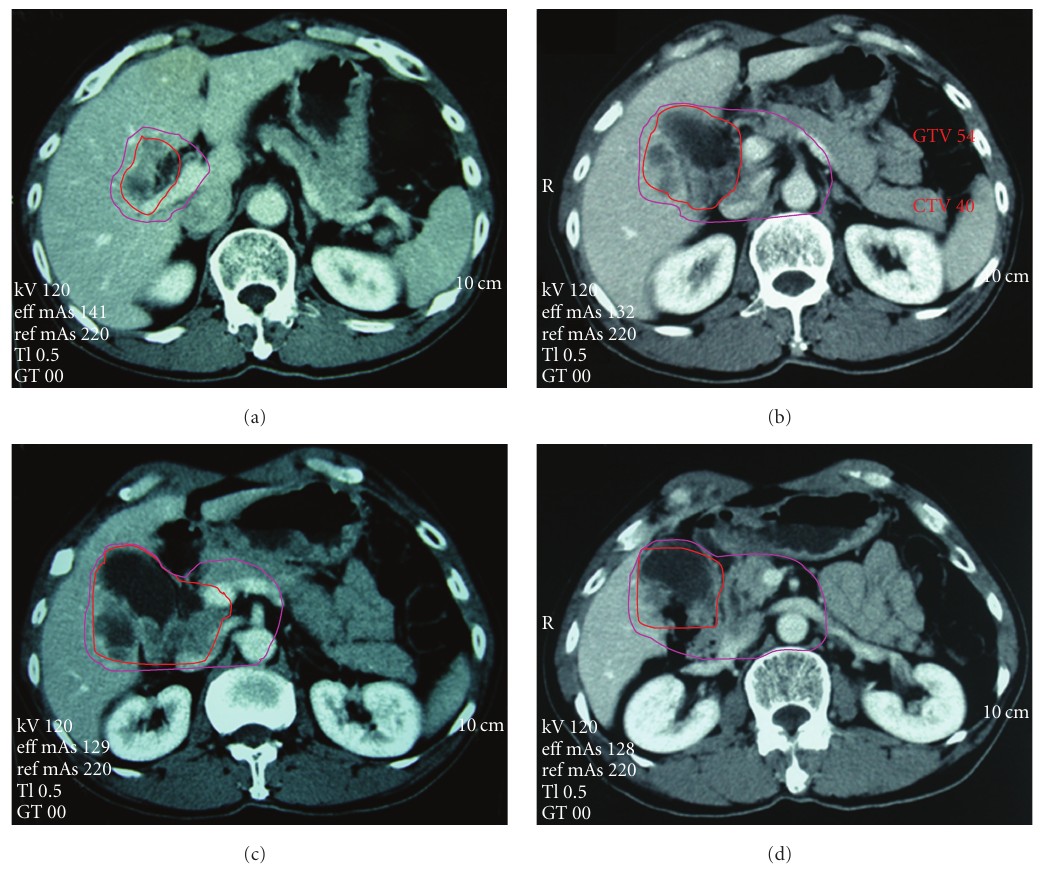
Figure 1: CT sections showing contours before radiotherapy. Radiation ports encompassed (a-b) regions of the liver involved by the gallbladder tumor and (c-d) carcinoma located at the neck of the gallbladder. GTV54 and CTV40 have been shown in the slice. Abbreviation: CTV: clinical target volume with pink lines; GTV: gross tumor volume with red lines.